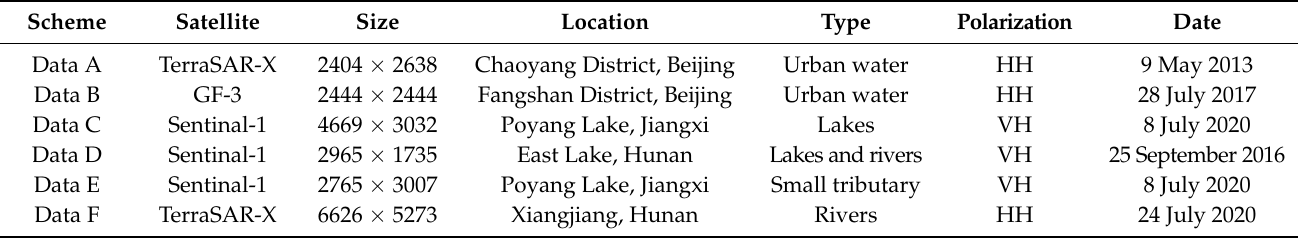
Table 2. List of SAR dataset used in this work.